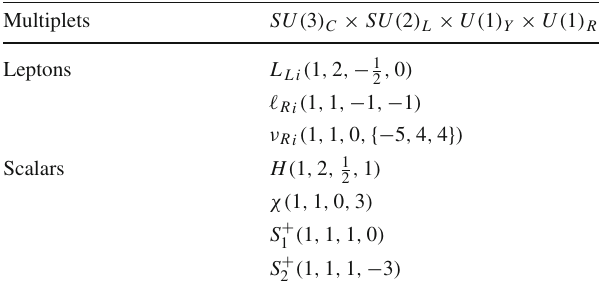
Table 3 Quantum numbers of the fermions and the scalars in Dirac seesaw model Multiplets